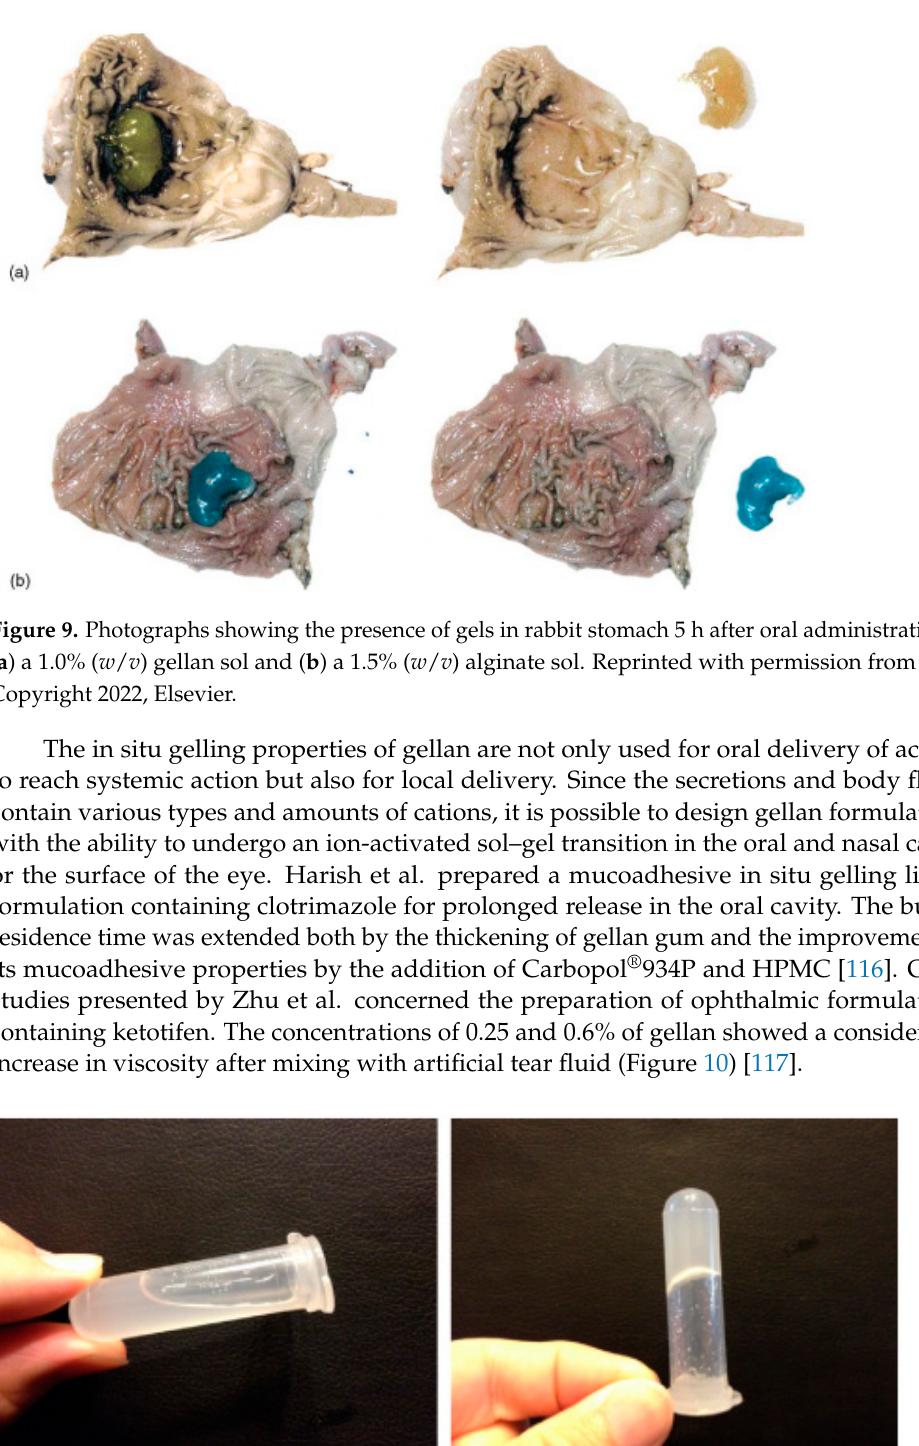
Figure 10. In vitro hydrogel formation with in situ gels (0.6%) and artificial tears [117].